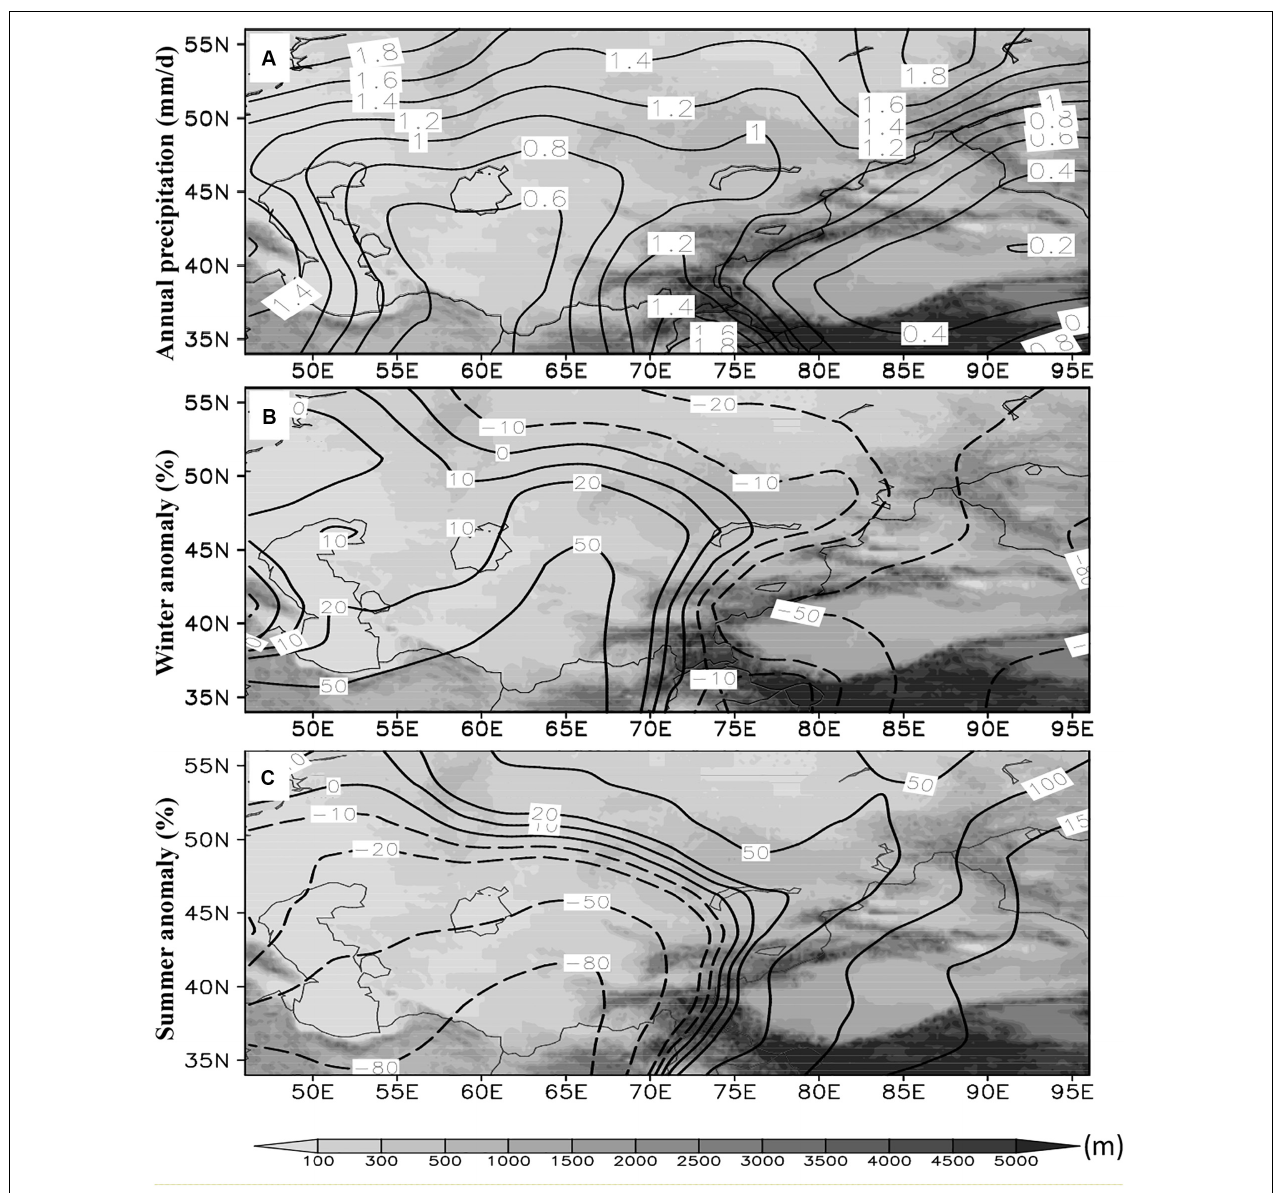
FIGURE 1 | Distribution of the (A) daily precipitation throughout the year (contours; units: mm day − 1 ) and anomalies of daily precipitation (contours; units: %) in (B) winter and (C) summer in Central Asia from 1979 to 2017. Topographic features are shown by shading (units: